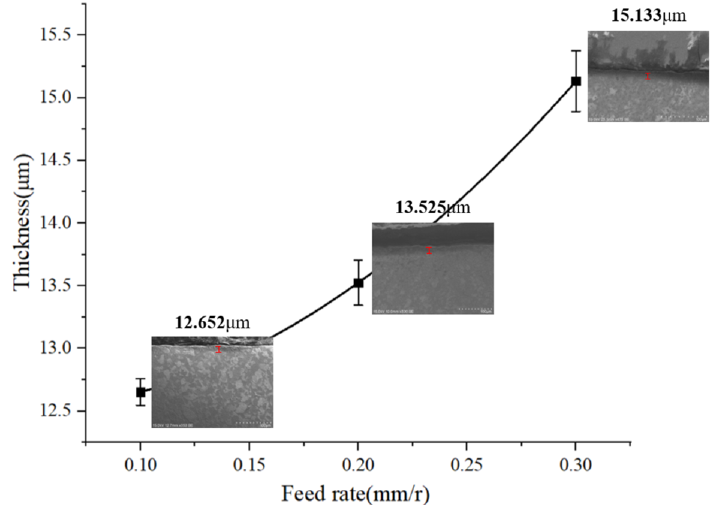
Figure 22. Variation of metamorphic layer thickness with feed rate. Figure 23 is a line graph of the variation of the thickness of the metamorphic layer in regards to the cutting speed when the feed rate is 0.1 mm/r. It can be found that with the increase in cutting speed, the thickness of the machined metamorphic layer of the contour bevel gears increases gradually. From the simulation analysis in Figure 10A,B, it can be seen that the increase in cutting speed can cause an increase in surface strain and strain rate, resulting in the grain refinement of the metamorphic layer and increasing the thickness of the metamorphic